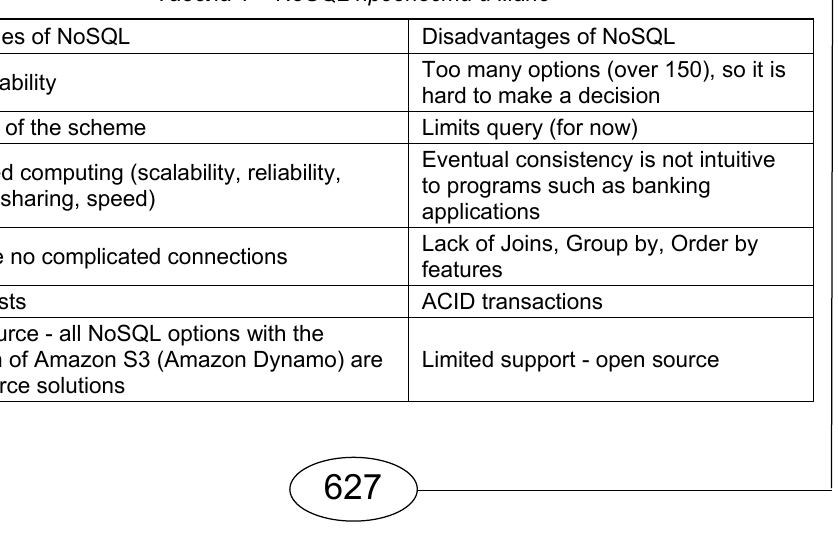
Table 1 – NoSQL advantages and